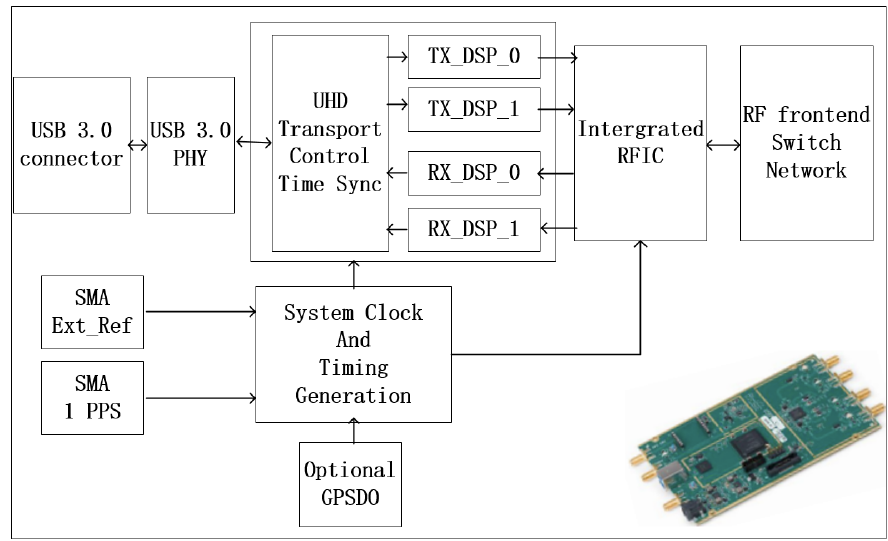
Figure 13 USRP B210 structure diagram.